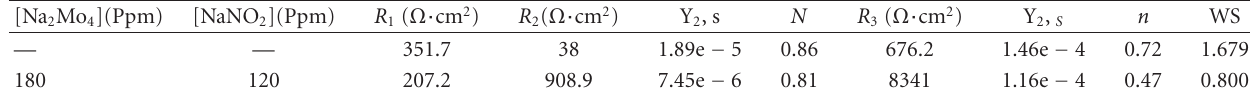
Table 3: Parameters obtained from the fitting process with the equivalent circuit in Figure 9.